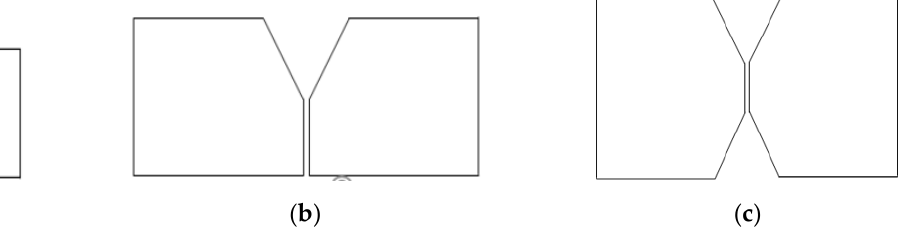
Figure 2. Typical weld joint configurations for Tandem SAW: ( a ) square groove; ( b ) Y (single V) groove; ( c ) double Y groove.